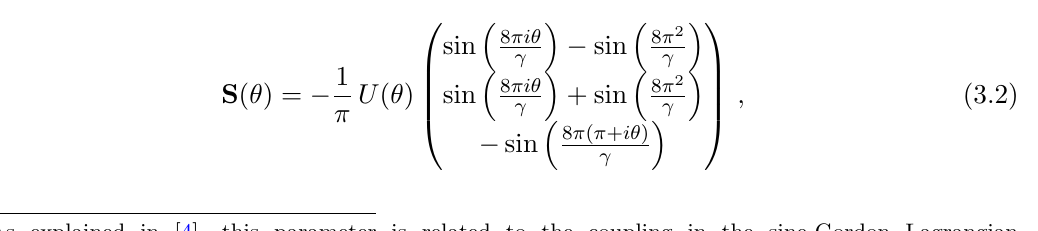
Figure 5 . ( a ) Analytic structure of the Gross-Neveu anti-symmetric S-matrix in the Mandelstam plane. There is a zero at s = 0 (in green), a bound state pole at s = m 2 and a t-channel pole in lighter blue. The green, blue and red dashed lines are respectively the regions below the left cut, between s 2 [0 ; 4 m 2 ] and above the right hand cut where we impose unitarity. ( b ) Numerical results for the corresponding regions in the (cid:18) = (cid:11) + i(cid:12) plane wit N = 7 ( m GN = 2 cos( (cid:25)= 5)) and n grid = 75. The top panel in green depicts the zero at (cid:18) = i(cid:25) ( s = 0). The middle panel in blue shows the bound state and t-channel poles. In the red bottom panel we see that unitarity is saturated (solid curve representing the absolute value of the